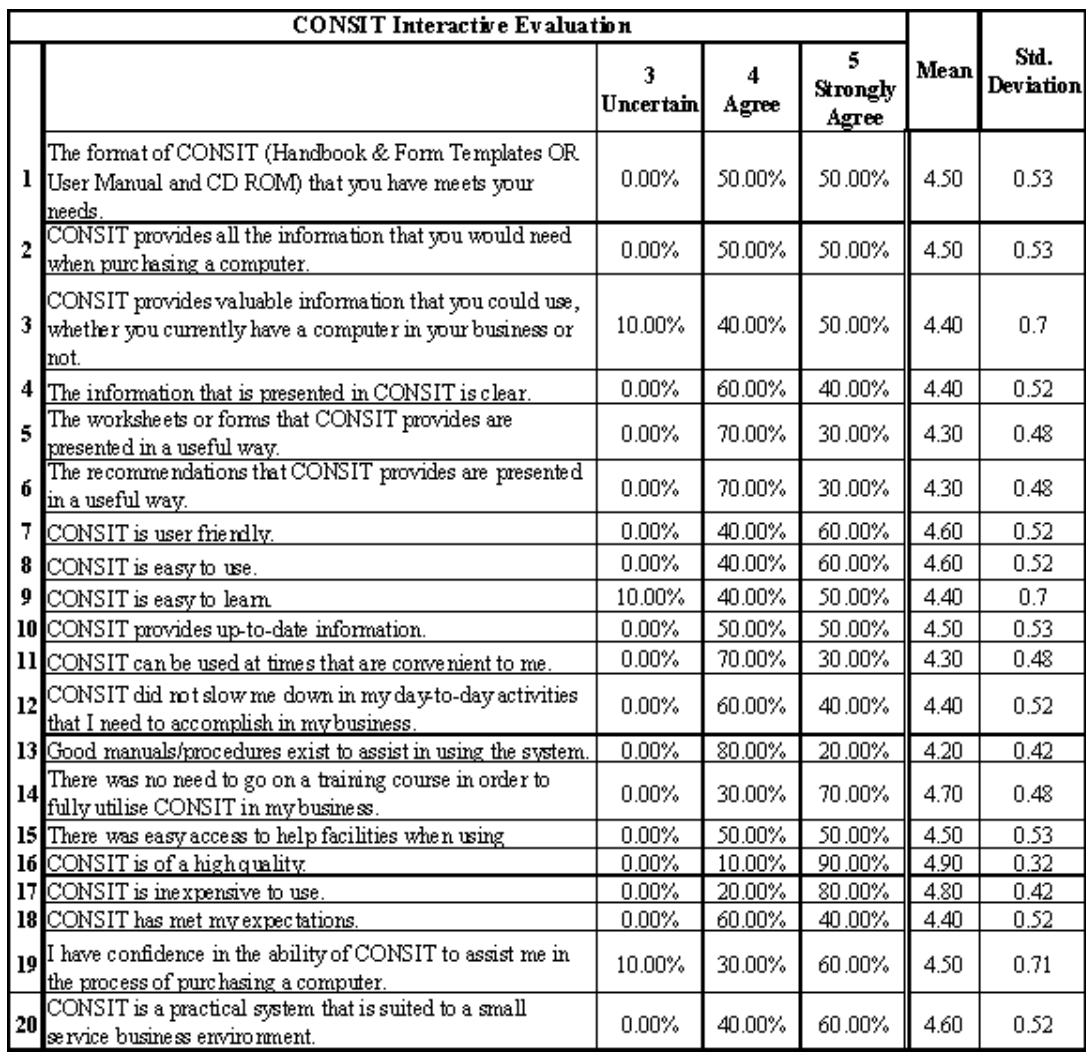
Table 6 Technical evaluation of